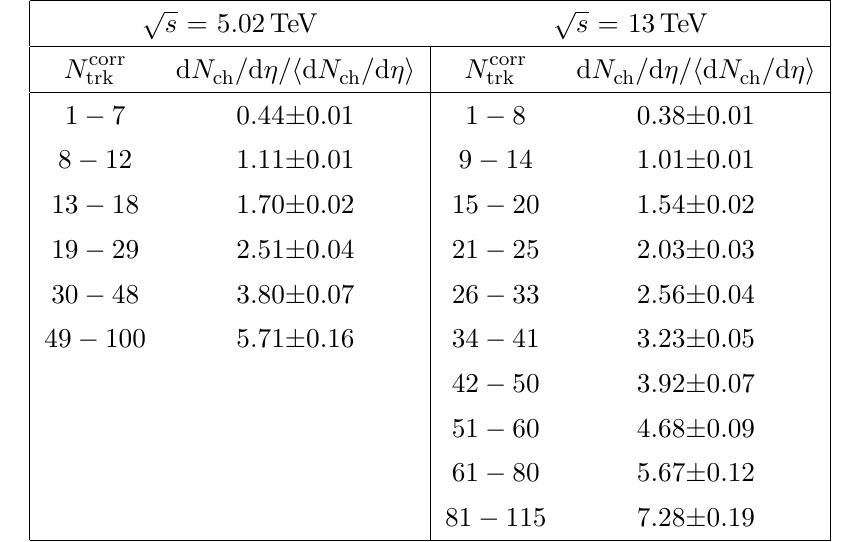
Table 1 . The corrected tracklet N corr intervals and the corresponding relative charged-particle trk multiplicity densities d N / d η/ h d N / d η i along with their systematic uncertainties are listed for ch ch √ pp collisions at s = 5.02 and 13